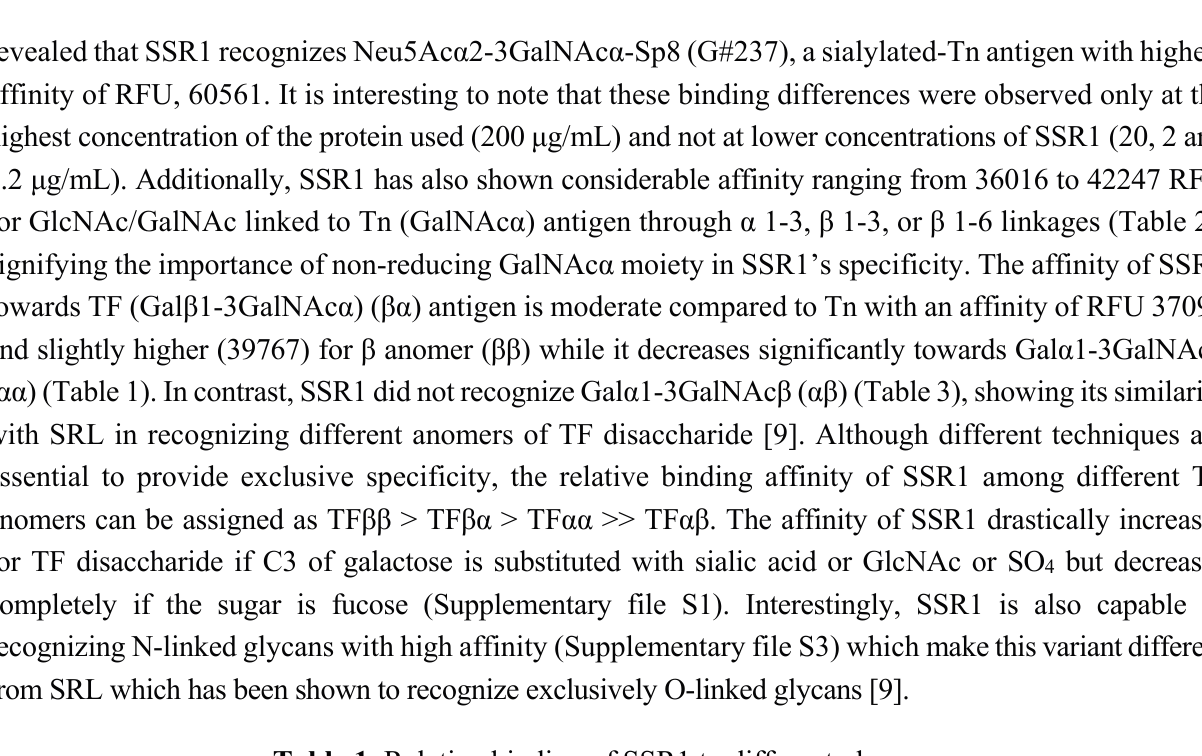
Table 1. Relative binding of SSR1 to different glycans. Glycan No.